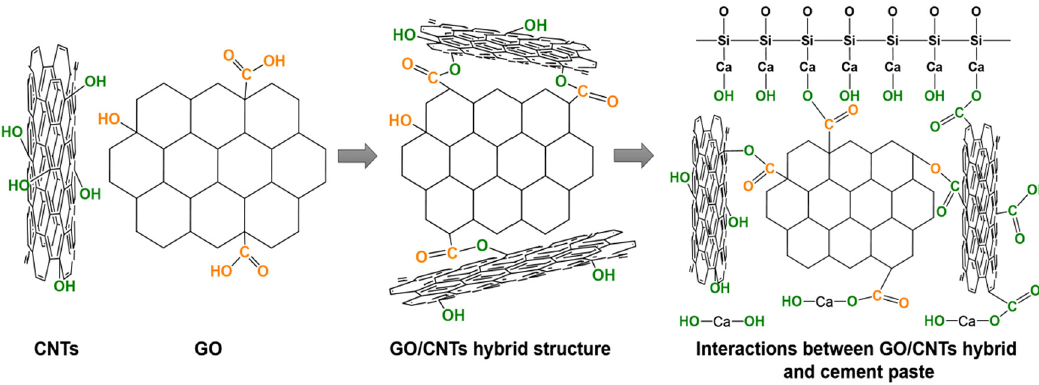
Figure 29: Mechanism of hybrid GO/CNTs reinforcement for cement pastes [ 147 ]